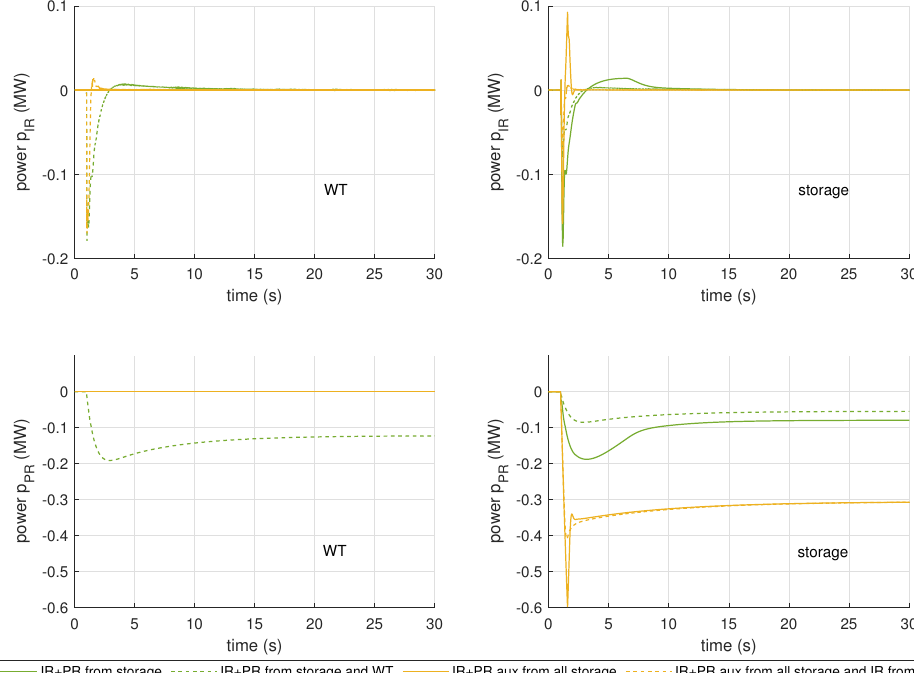
Figure 17. Contributions of WT and storage units to synthetic inertia ( top charts ) and primary reserve ( bottom charts ) for scenario HL-HR under different control